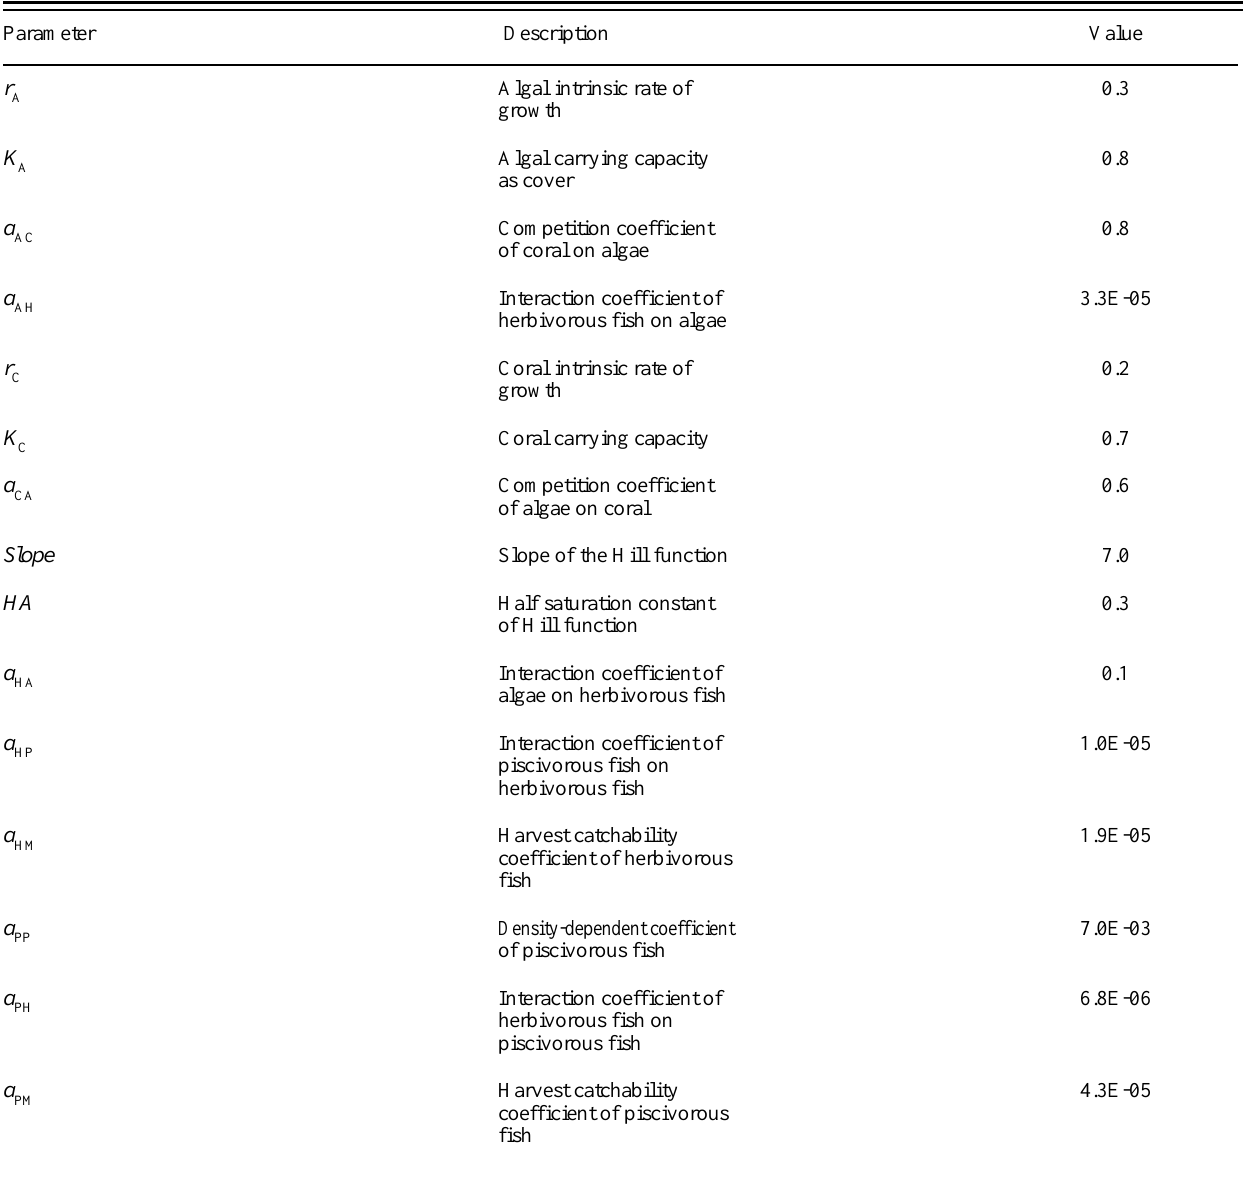
Table 3 . Parameter values and initial conditions used in baseline